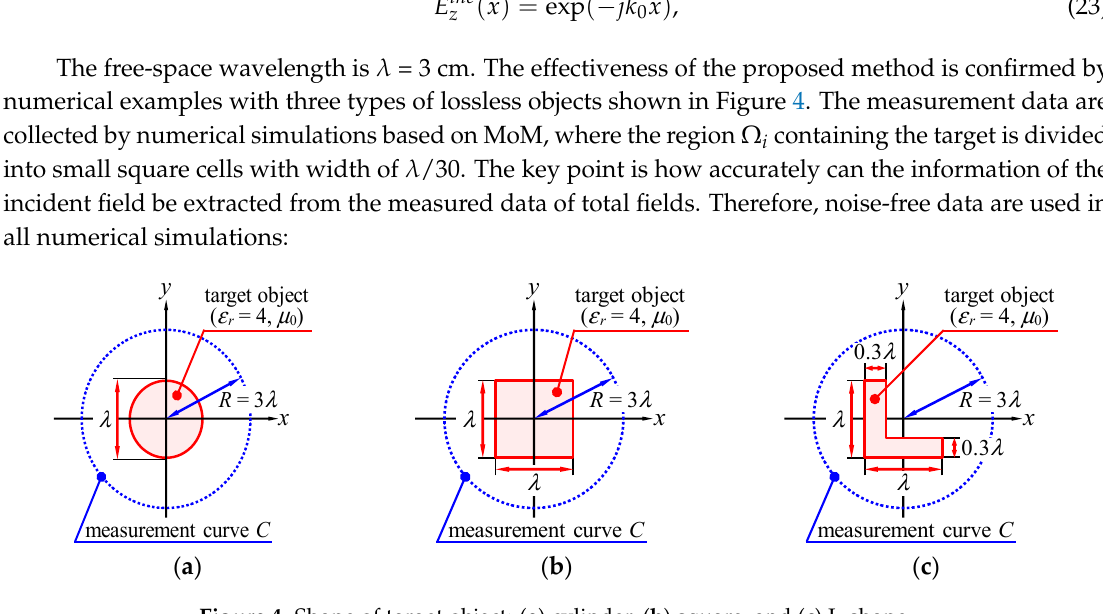
Figure 4. Shape of target object: ( a ) cylinder, ( b ) square, and ( c ) L-shape.